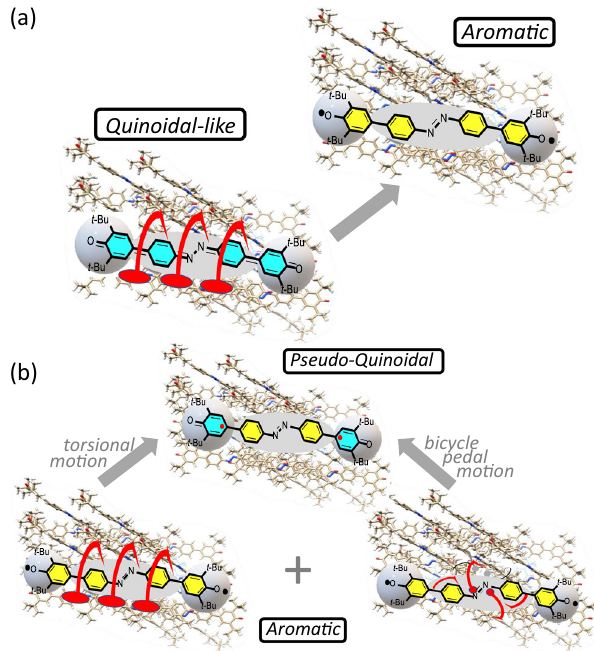
Fig. 6 Sequential vs simultaneous action of torsion and bicycle pedal motions. Simulations (not at scale) of the dihedral torsion motion of the azobenzene relative to the phenoxyls provoking the Q → A transformation ( a ), and of the combined torsional plus bicycle pedal motions of the central azobenzene moiety provoking the A → PQ transformation ( b